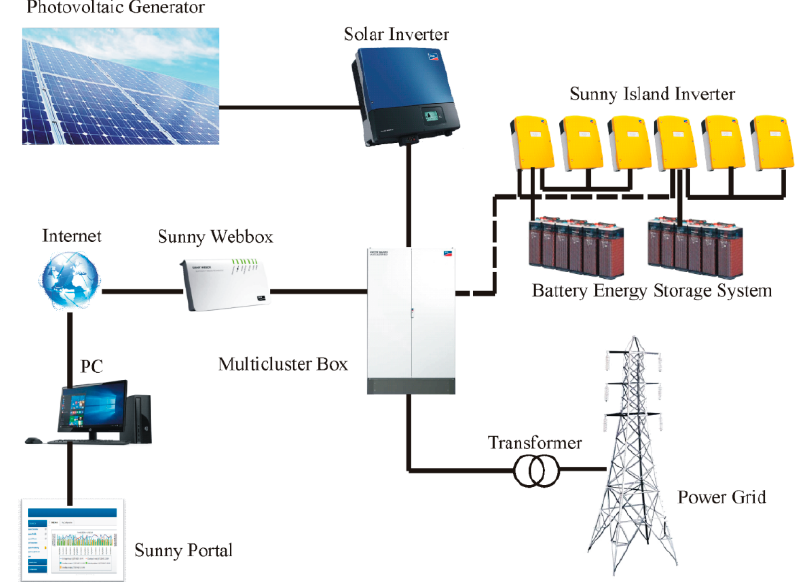
Figure 1. Block diagram of the Centro de Investigación en Energías Renovables del Departamento del Chocó, Colombia (CIERCHOCÓ) building integrated photovoltaic system (BIPVS).